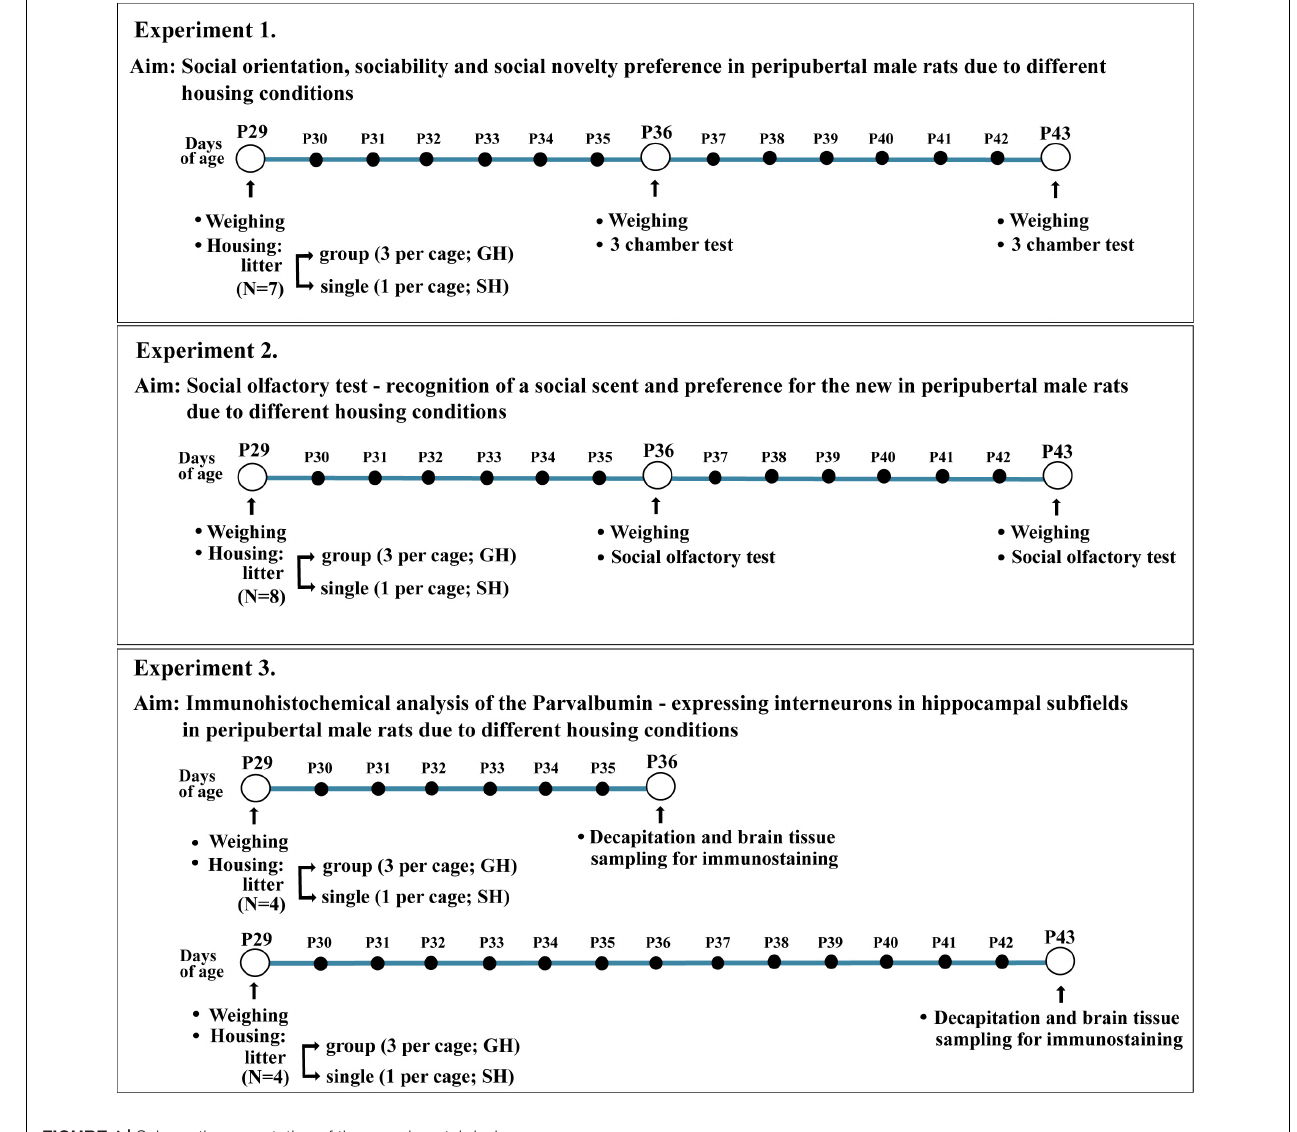
FIGURE 1 | Schematic presentation of the experimental